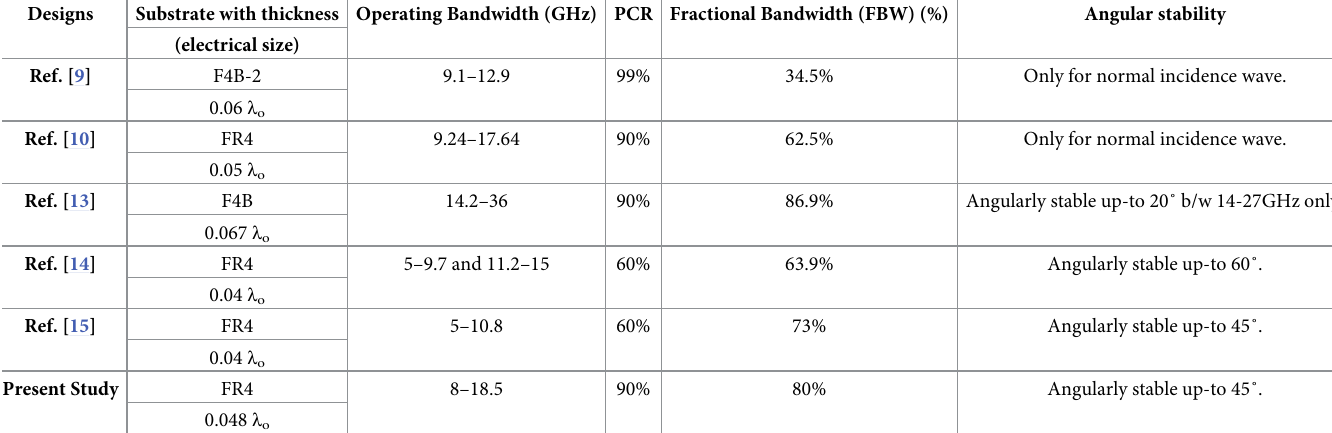
Table 1. Comparison with other cross-polarization conversion metasurface designs.